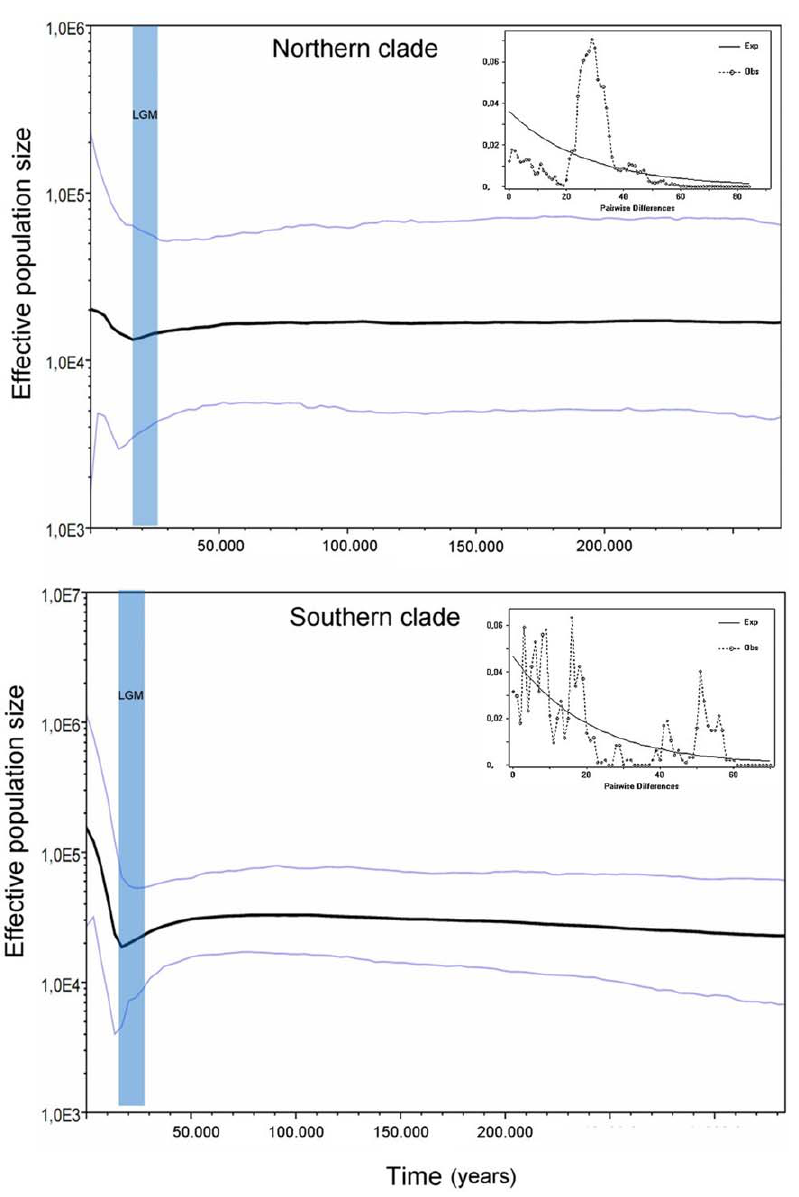
Figure 6. Prediction of the historical effective population size in L.pictus . Bayesian skyline plots and mismatch analysis for the two major mtDNA clades of L. pictus . The black line is the temporal trend of the mean of effective population size. Vertical light blue band corresponds to the LGM.